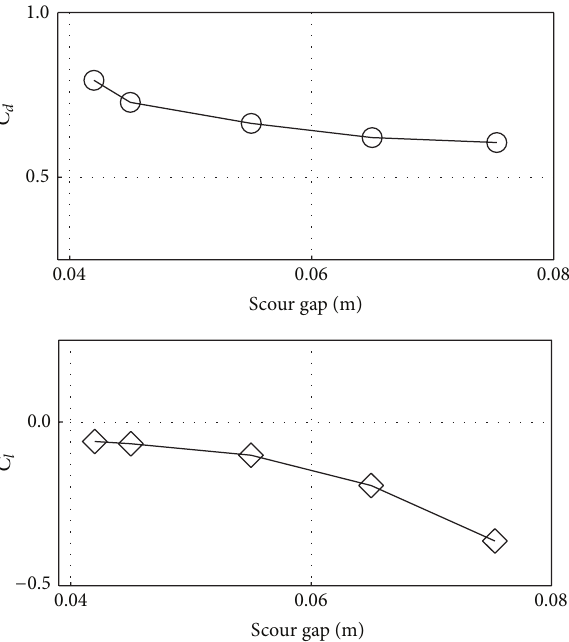
Figure 10: Effect on (a) drag coefficient ( 𝐶 𝑑 ) and lift coefficient ( 𝐶 𝑙 ) at cylinder surface of different time